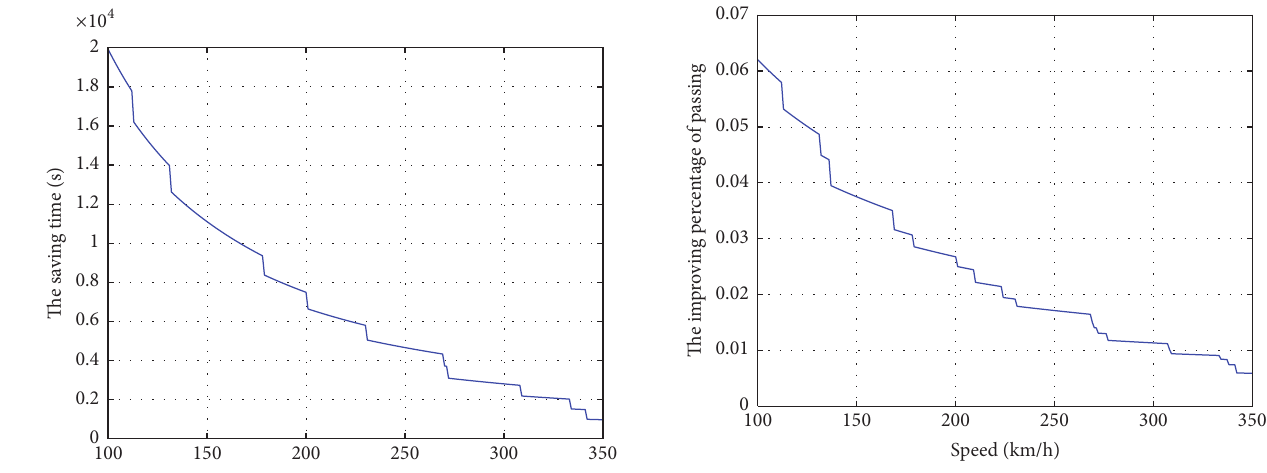
Figure 9: The improving percentage of passing. where 𝑘 1 and 𝑘 2 represent the coefficients, as described above. 𝑁 V represents the passing capacity under the variable section. 𝑁 𝑓 represents the passing capacity under the fixed